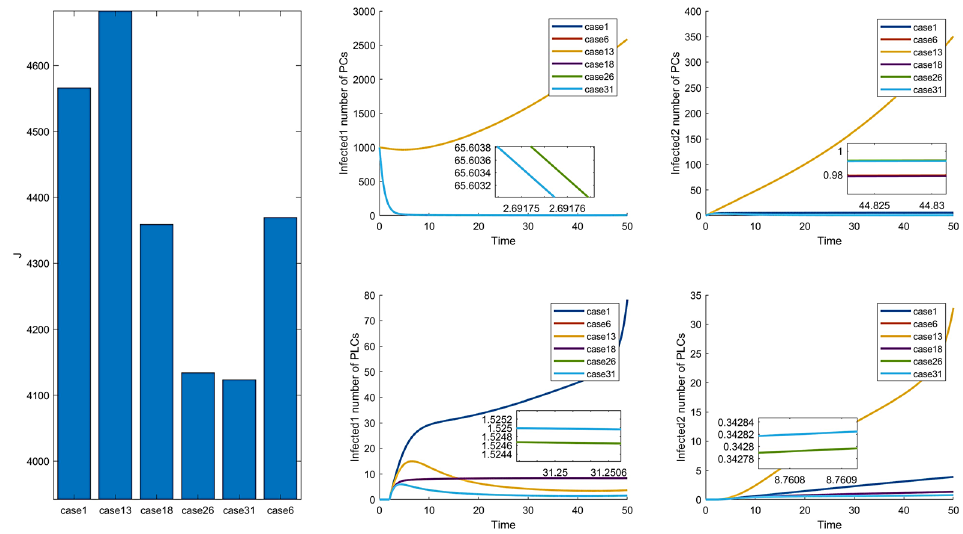
Figure 11. Costs and effects of control combinations with better effects in Figures 7–10.